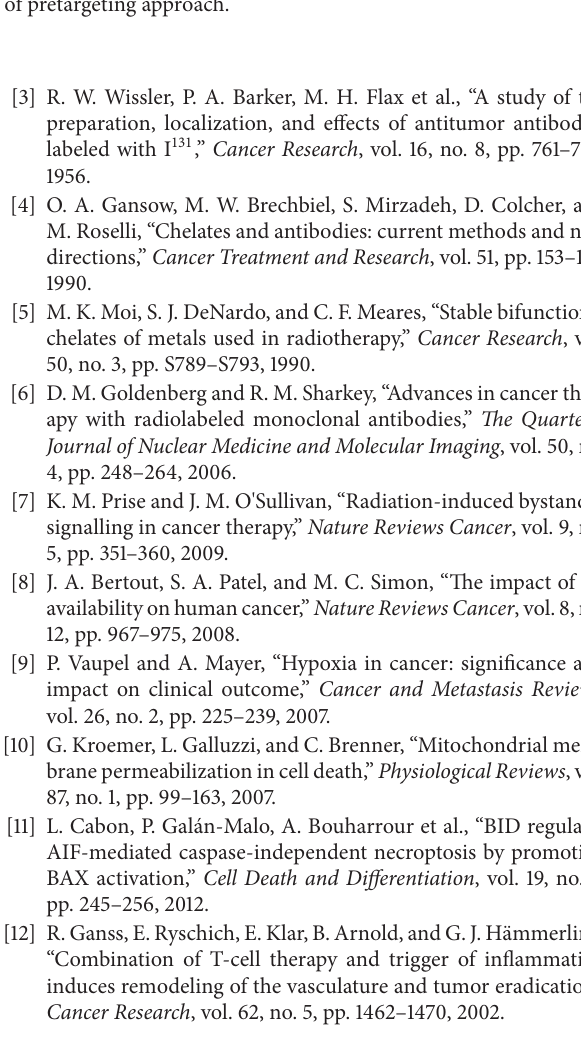
Figure 1: Schematic diagram of pretargeting